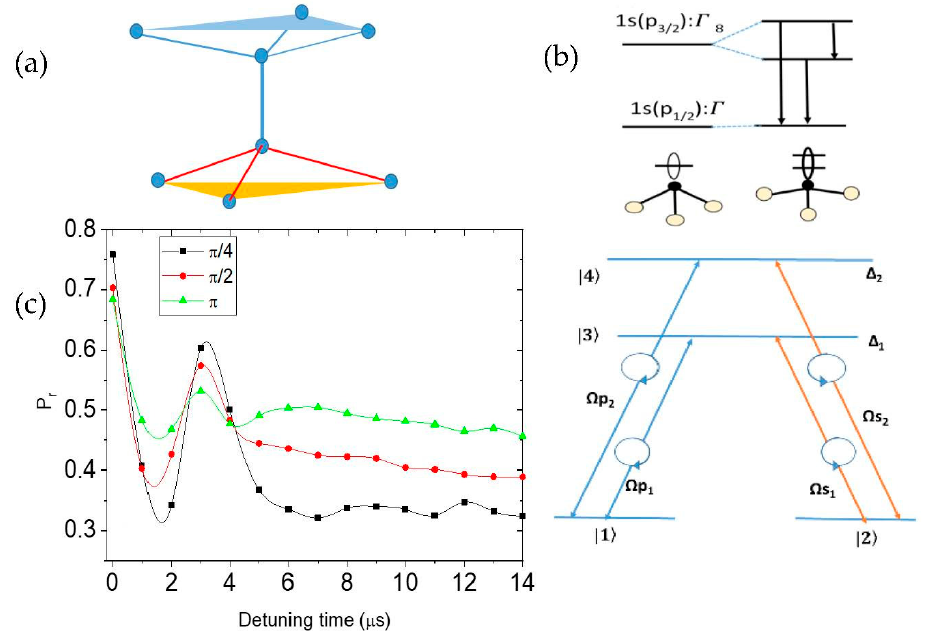
Figure 6. ( a ) Shockley model of topological phase [17]. Qubit arrangements show two connected triangles as closed loops and describe spin-orbit interactions. ( b ) The boron acceptor can be present in the GB, which removes the degeneracy of the 1s(p 3/2 ) spin-orbit split level, hence creating a strong splitting of the energy levels [23]. A four-level energy (|1>–|4>) diagram of the spin triplets of a boron center showing the Rabi frequencies ( Ω s,p ) and the detuning is Δ 1 = Δ 2 = Δ [48]. ( c ) Shows the variation of P r (or magnetoresistance) with detuning time (magnetic field) when spin-orbit is included. The qubits are also rotated in different angles from π /4 to π to show the intensity variation of the side peak, which is a signature of RSOC.